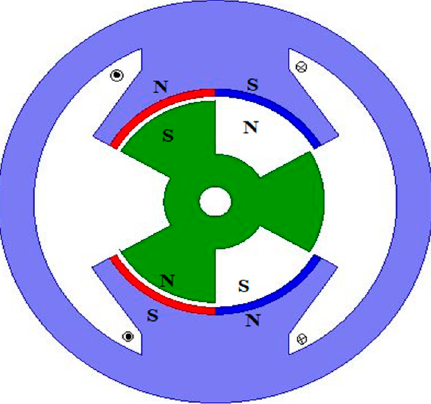
Figure 4. 1-phase, two/three-pole stator-PM generator [15].